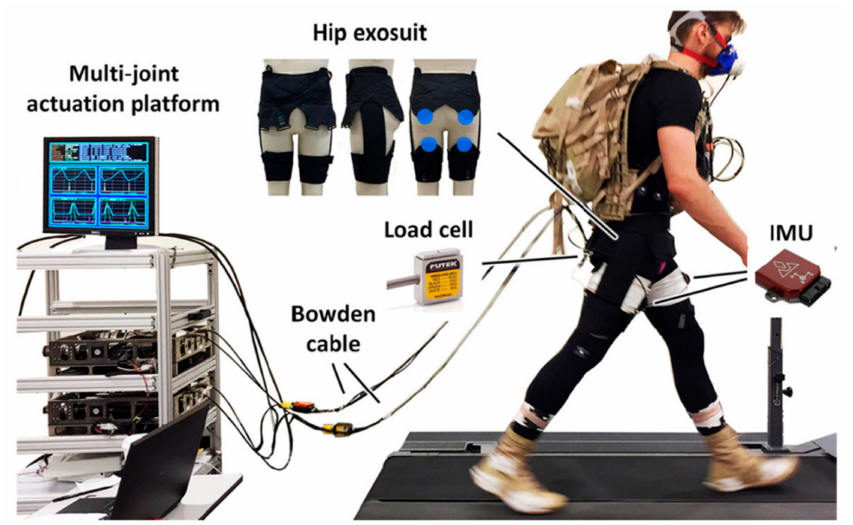
Figure 8. Soft exosuit system for hip movement [78] (Open